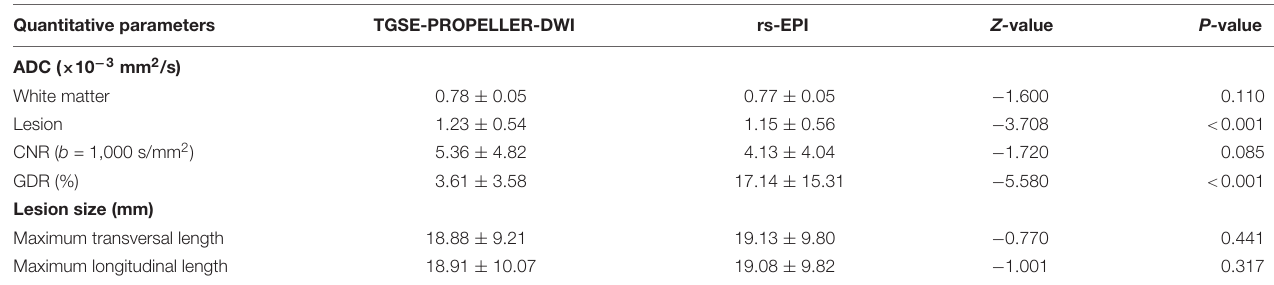
FIGURE 2 | Coronal T2-weighted imaging (T2WI) images (A–C) , coronal TGSE-PROPELLER-DWI b1000 images (A1–C1) , and coronal rs-EPI b1000 images (A2–C2) . (A,A1,A2) : patient 1, male, 62 years old, left orbital lymphoma, scores of geometric distortions, susceptibility artifacts, lesion conspicuity, and overall image quality of TGSE-BLADE-DWI were 4, 4, 4, and 4, respectively, while those of rs-EPI were 3, 2, 3, and 3, respectively. (B,B1,B2) : patient 2, male, 50 years old, left orbital fibroma, scores of geometric distortions, susceptibility artifacts, lesion conspicuity, and overall image quality of TGSE-BLADE-DWI were 4, 4, 4, and 4, respectively, while those of rs-EPI were 3, 3, 4, and 4, respectively. (C,C1,C2) : patient 3, female, 61 years old, left orbital hemangioma, scores of geometric distortions, susceptibility artifacts, lesion conspicuity, and overall image quality of TGSE-BLADE-DWI were 4, 4, 4, and 4, respectively, while those of rs-EPI were 2, 3, 2, and 2, respectively. TABLE 3 | Quantitative parameters between TGSE-PROPELLER-DWI and